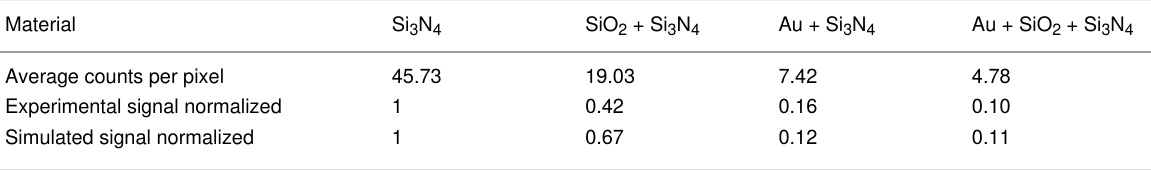
Table 1: Bright-field STIM contrast comparison: Intensity of the transmitted signal from 0 to